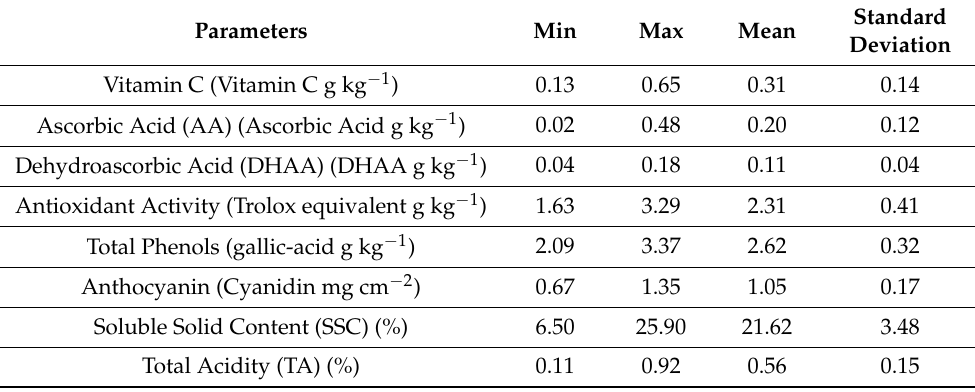
Table 1. Range values and statistical distribution of internal constituents’ quality attributes of fresh goji